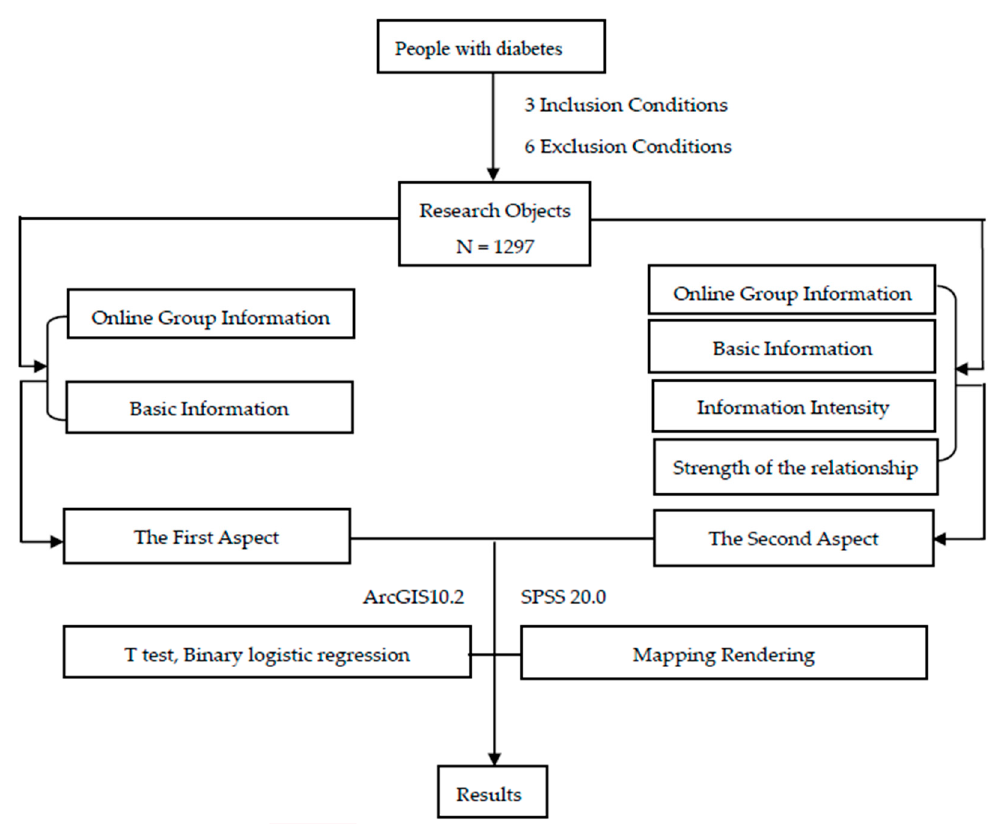
Figure 1. The flow chart of the entire research design.